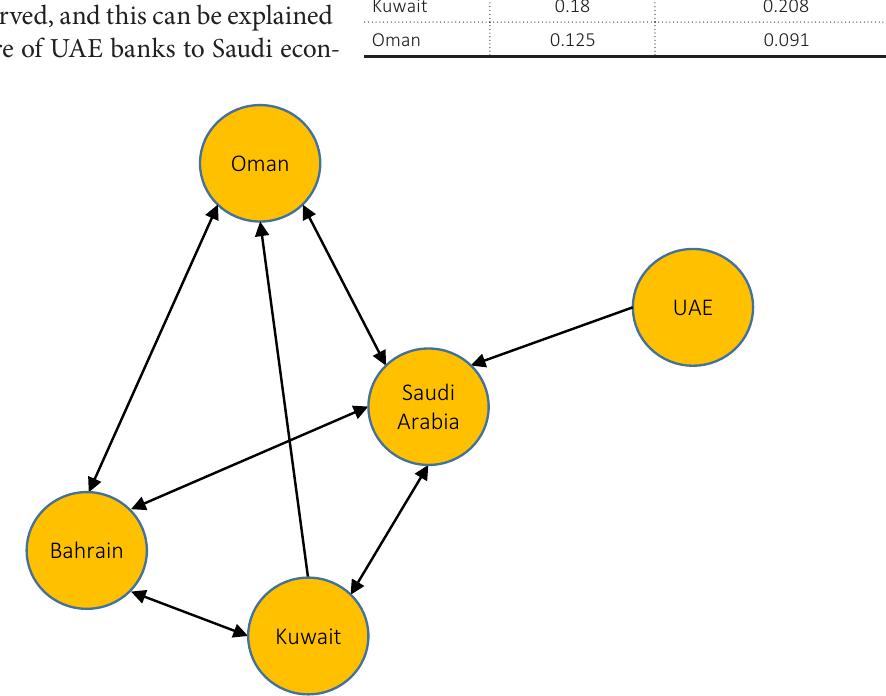
Figure 1. Partial correlation